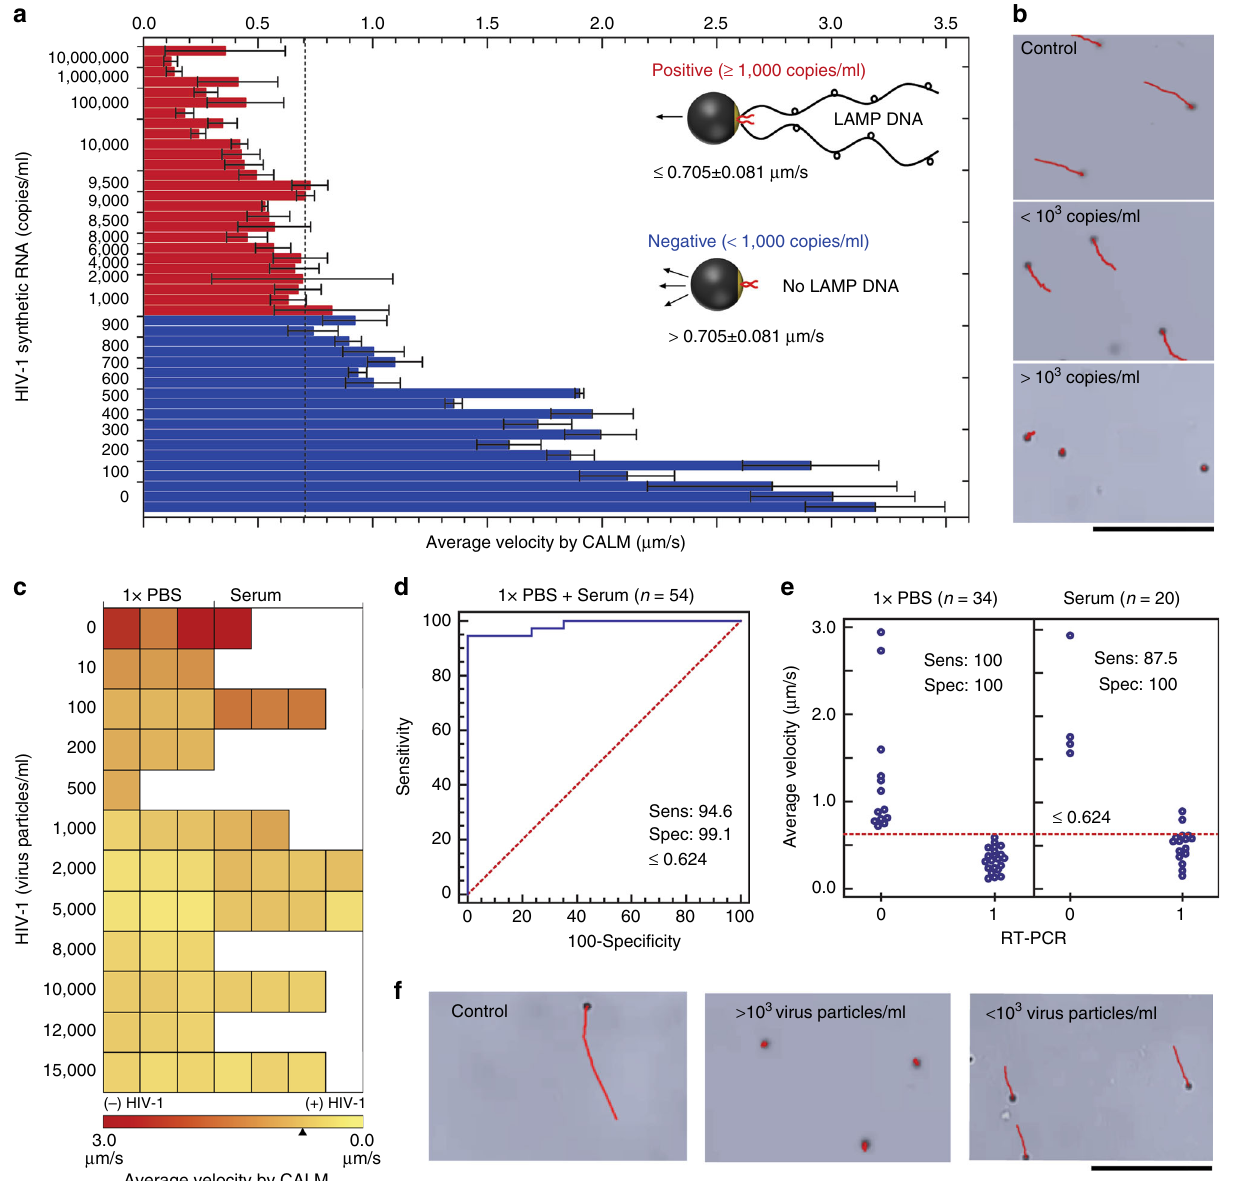
Fig. 6 HIV-1 detection using the CALM system. Synthetic HIV-1 RNA standard detection: a bar graph shows the average velocity of motors recorded by the CALM system for phosphate-buffered saline (1× PBS, pH 7.4) samples ( n = 45) spiked with different HIV-1 RNA concentrations. Vertical black dotted line indicates the average velocity at the threshold concentration of 1000 virus particles/ml; b representative digital images show the motion trajectories of motors in the absence of HIV-1 RNA (control) or the presence of HIV-1 RNA at concentrations above and below the threshold of 1000 copies/ml (scale bar = 100 μ m). HIV-1 particles detection: c heatmap of the average motor velocity measured by the CALM system for different virus concentrations spiked in 1× PBS ( n = 35) and serum ( n = 20). The average velocity of HIV-1 positive samples ( ≥ 1000 virus particles/ml) is ≤ 0.704 ± 0.08 µ m/s (yellow in color) and the average velocity of HIV-1 negative samples (<1000 virus particles/ml) is >0.704 ± 0.08 µ m/s (red in color); d receiver-operating characteristics (ROC) curve analysis of 1× PBS ( n = 35) and serum ( n = 20) samples spiked with different HIV-1 concentrations showing the assay detection sensitivity (sens) and speci fi city (spec) compared to real-time polymerase chain reaction (RT-PCR). The threshold value for virus concentration applied here was 1000 particles/ml. Samples with virus concentrations above and below 1000 particles/ml were classi fi ed as positive and negative, respectively; e vertical scatterplot analysis of virus spiked samples ( n = 54). The threshold value for average motor velocity applied here was 0.704 µ m/s that corresponds to 1000 particles/ml. Samples with velocities above and below 0.704 µ m/s were classi fi ed as 1 (positive) and 0 (negative), respectively; f representative digital images show the motion trajectories of motors in the absence of HIV-1 particle (control) and the presence of HIV-1 at concentrations above and below 1000 virus particles/ml (scale bar = 100 μ m). The results are expressed as the average values of three independent experiments and error bars represent standard